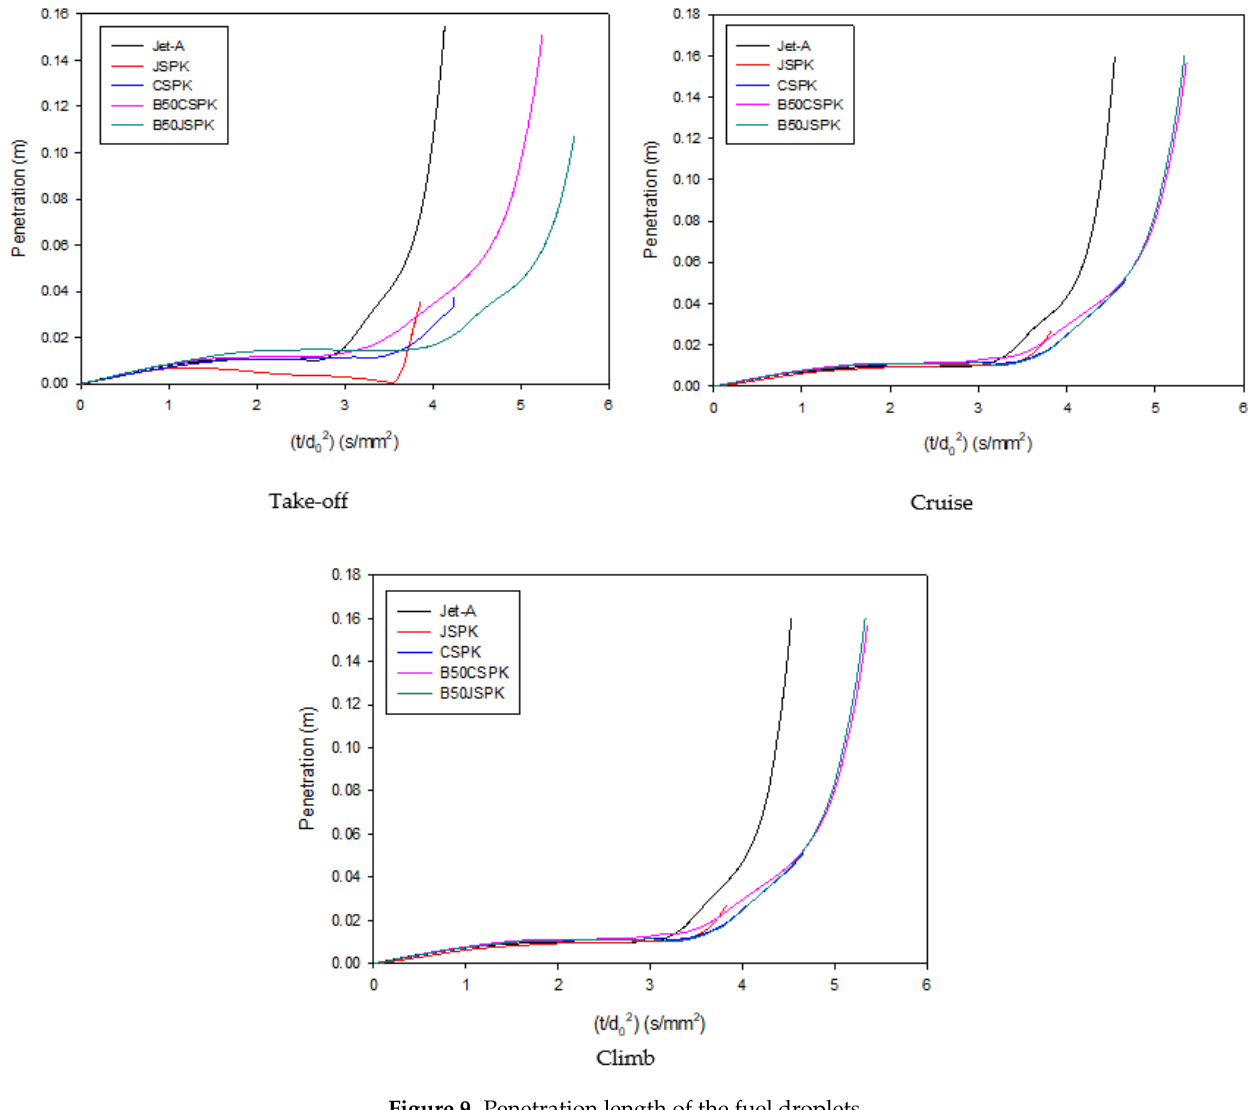
Figure 9. Penetration length of the fuel droplets.